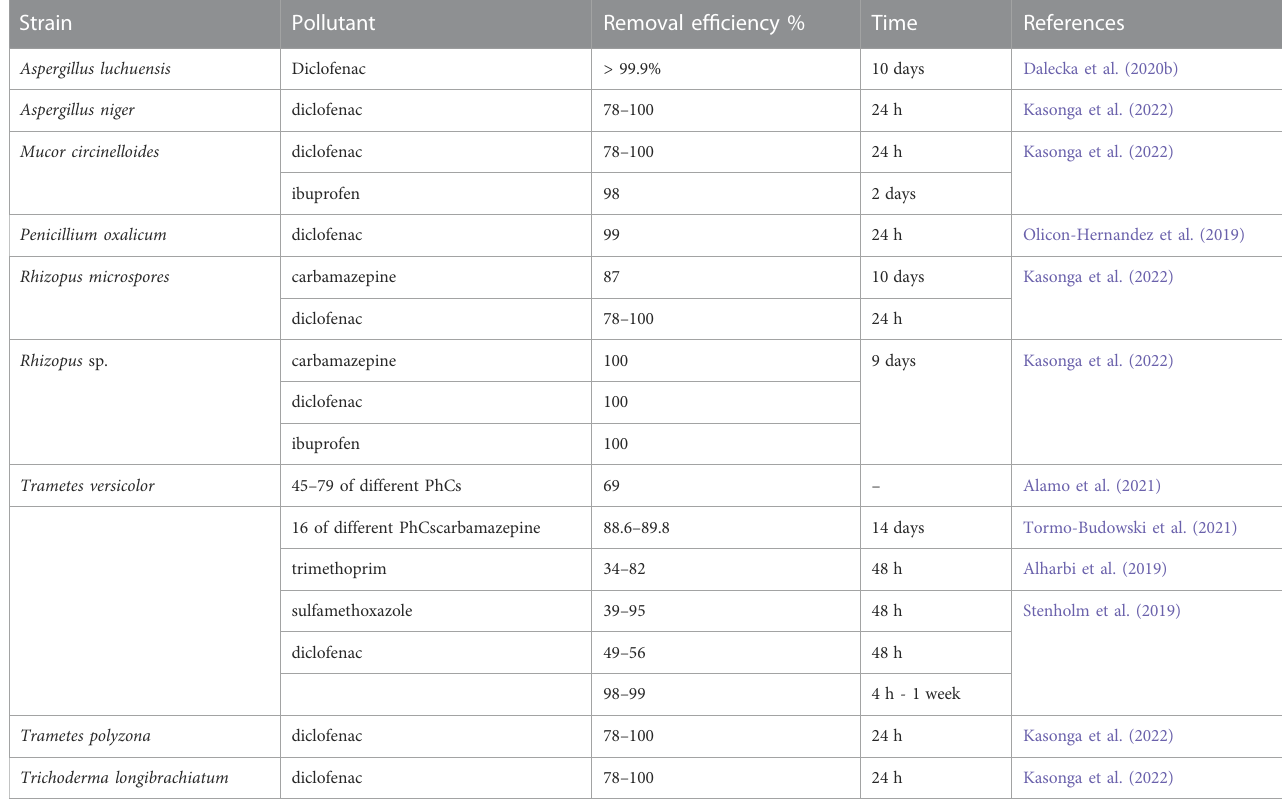
TABLE 2 Pharmaceutical compounds (PhCs) removal ef fi ciency by fi lamentous